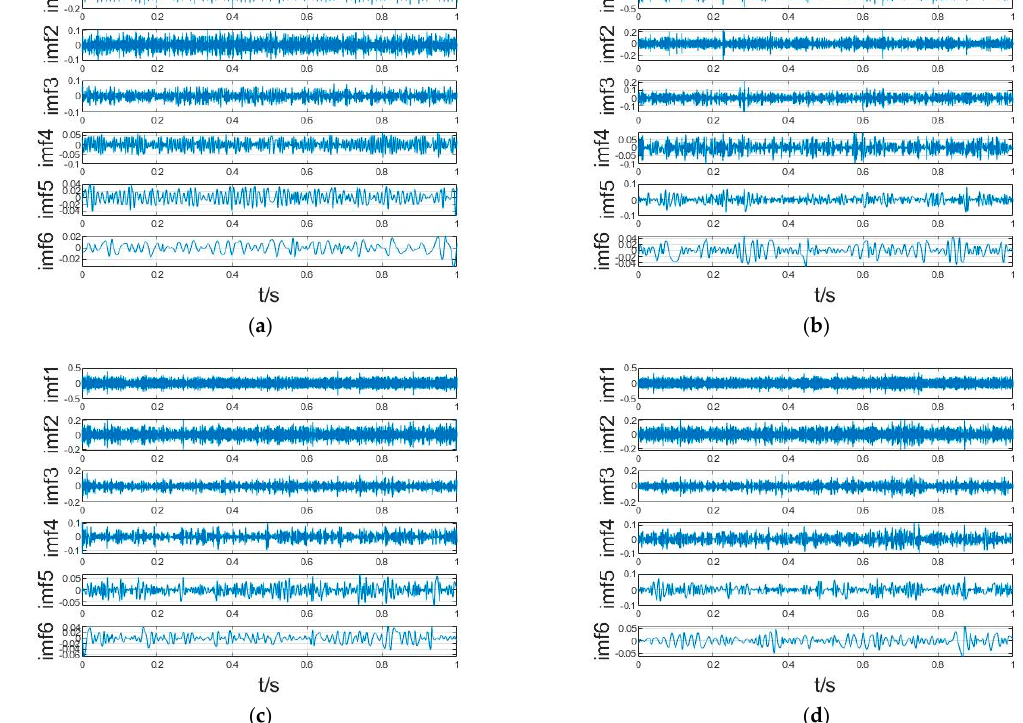
Figure 8. EMD in X-direction of the pump inlet pipe. ( a ) normal operation. ( b ) incipient cavitation. ( c ) cavitation. ( d ) severe cavitation.